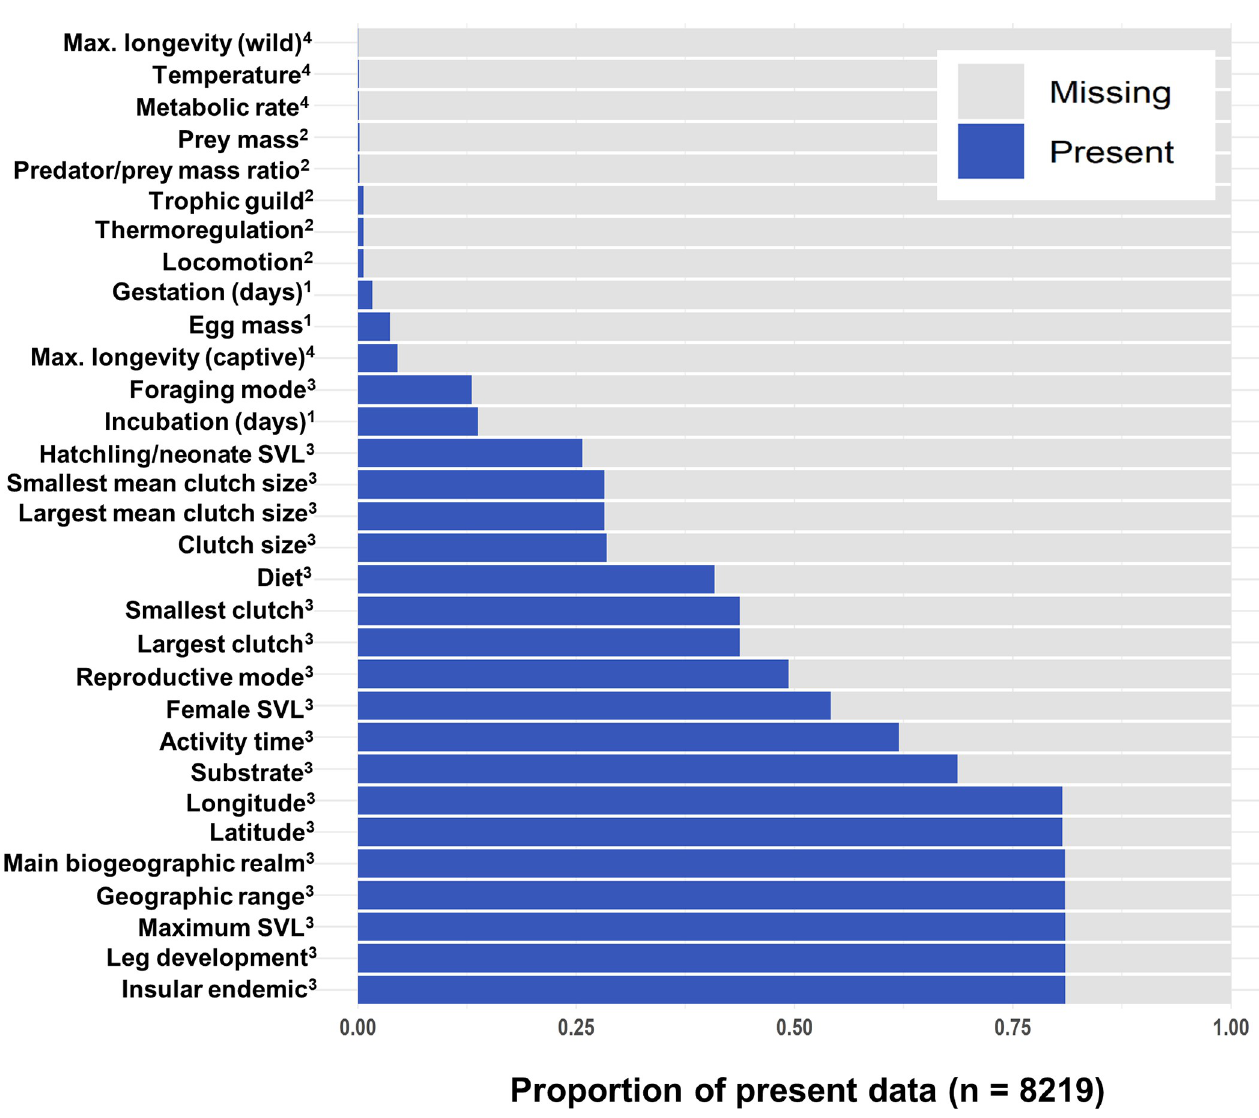
Fig 1. Visualization of missingness. Visualization of missingness (proportion of present vs. missing observations) in Squamata trait data obtained from the primary literature. Superscripts indicate the original sources of the trait data: 1) amniote life history database [12,13],2) vertebrate home range sizes dataset [14,15],3) traits of lizards of the world [16,17] and 4) AnAge [18,19].See S1 File for further detail on trait sources.